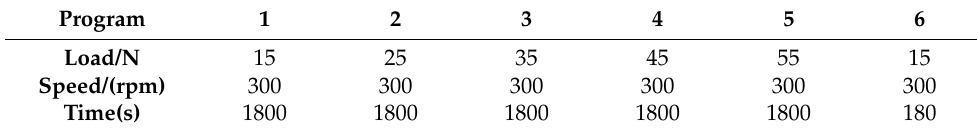
Table 4. The set test parameters for the dry sliding pin-on-disc